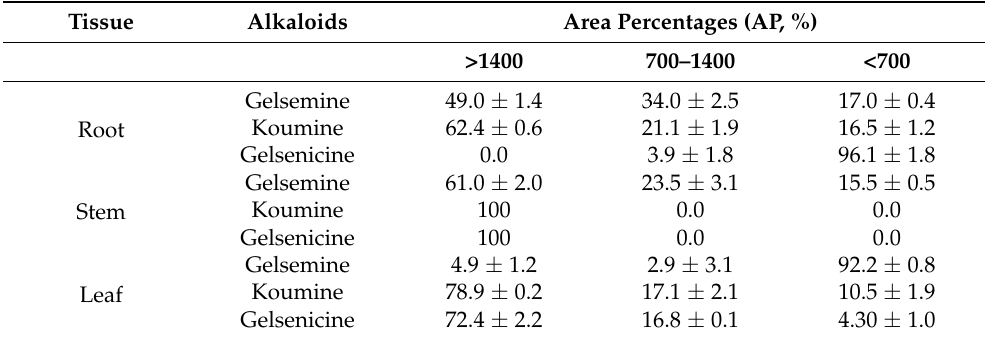
Table 1. Area percentages (AP) of gelsemine, koumine, and gelsenicine in different intensity range. Statistical significance was evaluated using Microsoft Excel software. Values were expressed as means ±